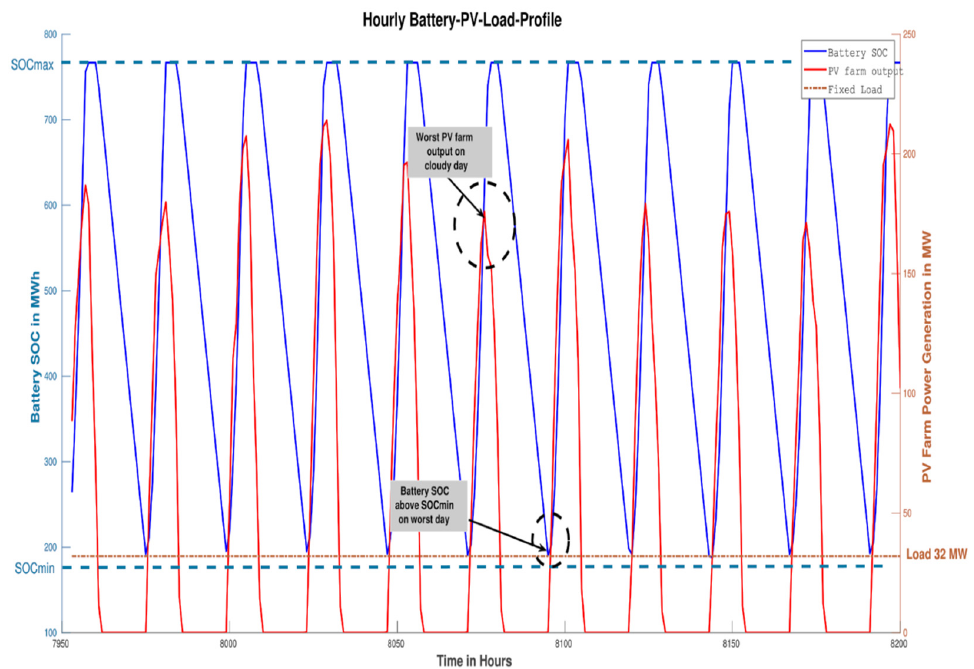
Figure 11. Hourly plant operation with PV-battery-load profiles for worst case scenario. In this figure, SOC represents State of Charge.